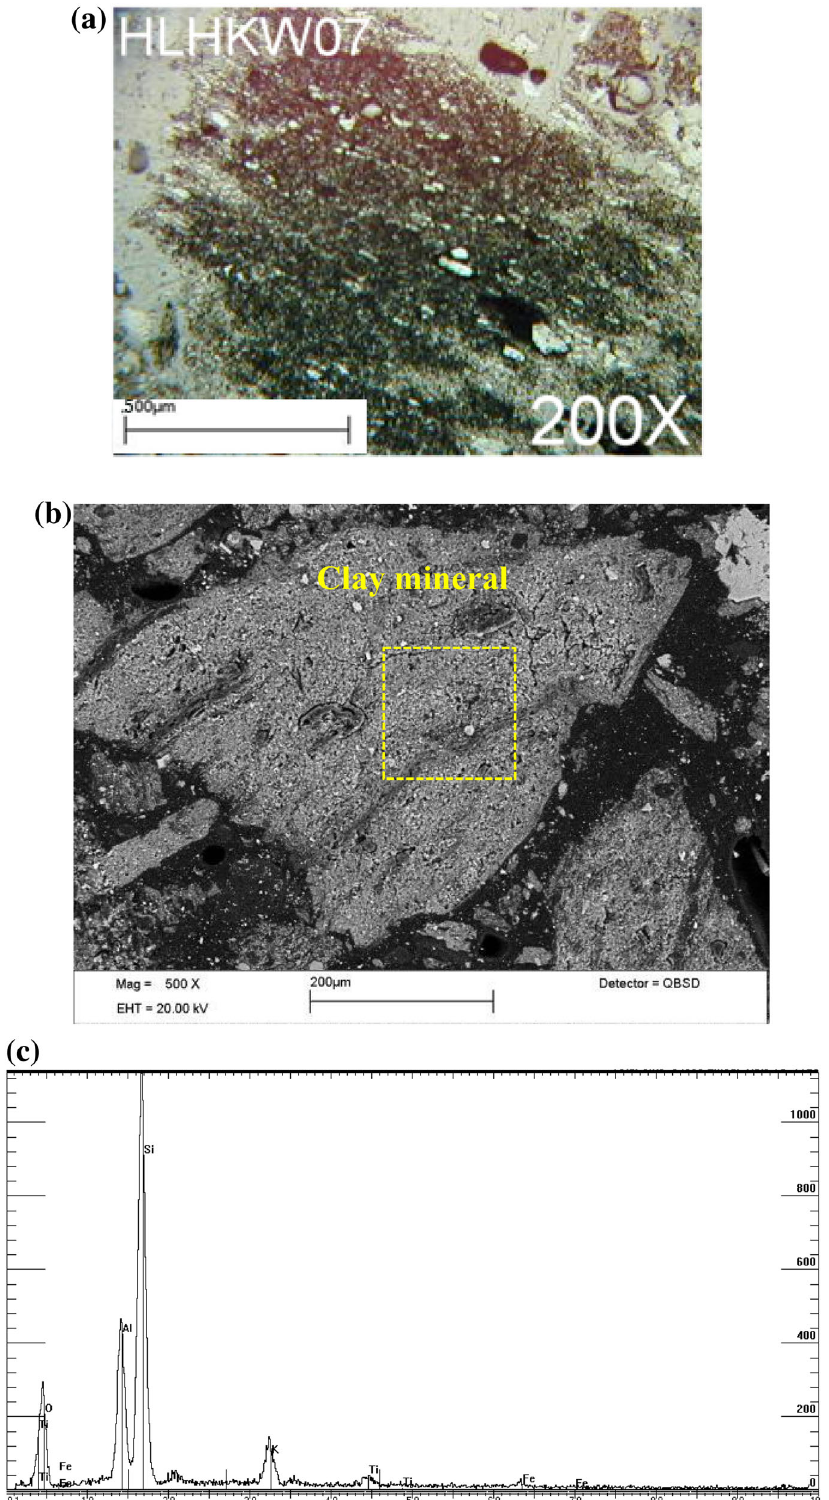
Fig. 1 Clay minerals in the Huolinhe coal. a Optical microscopy, reflected light; air; polarized light;200 9 . b SEM backscattered electron image. c X-ray energy spectrum diagram of the box in b , scanning area: 150 l m 9 150 l